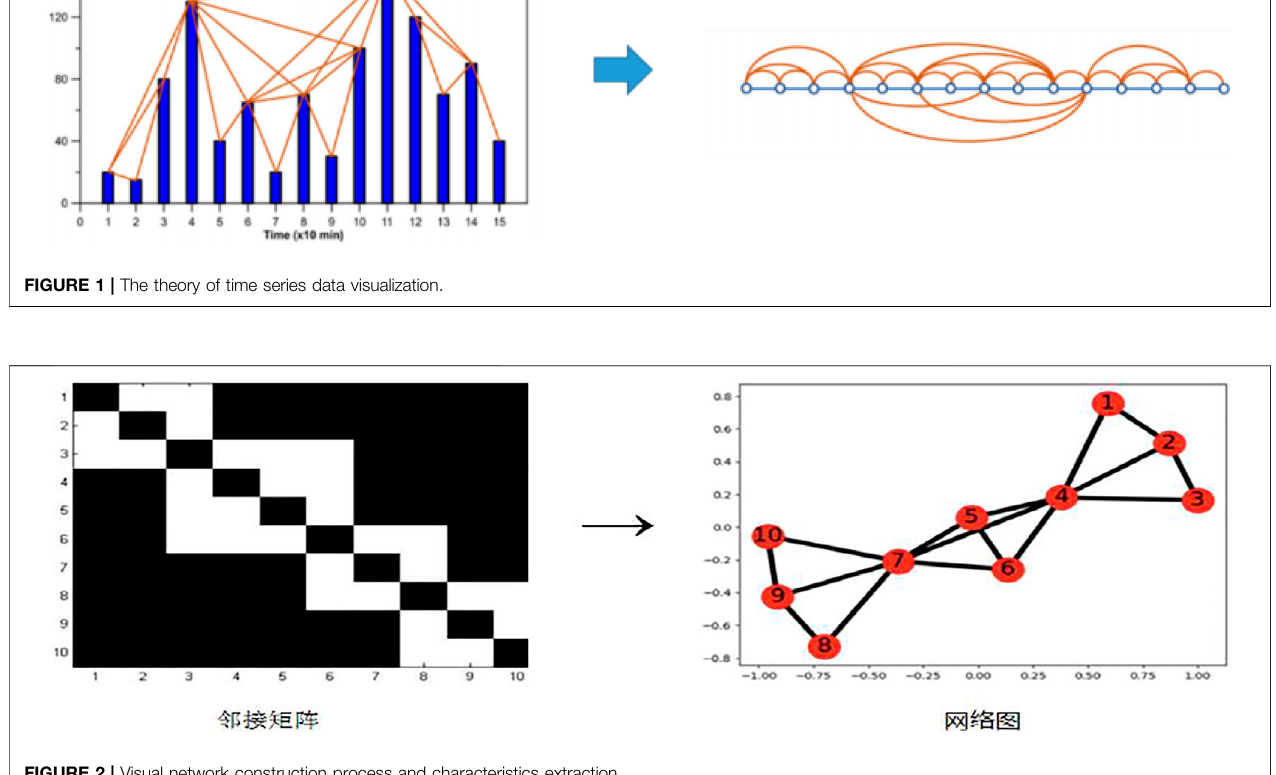
FIGURE 2 | Visual network construction process and characteristics